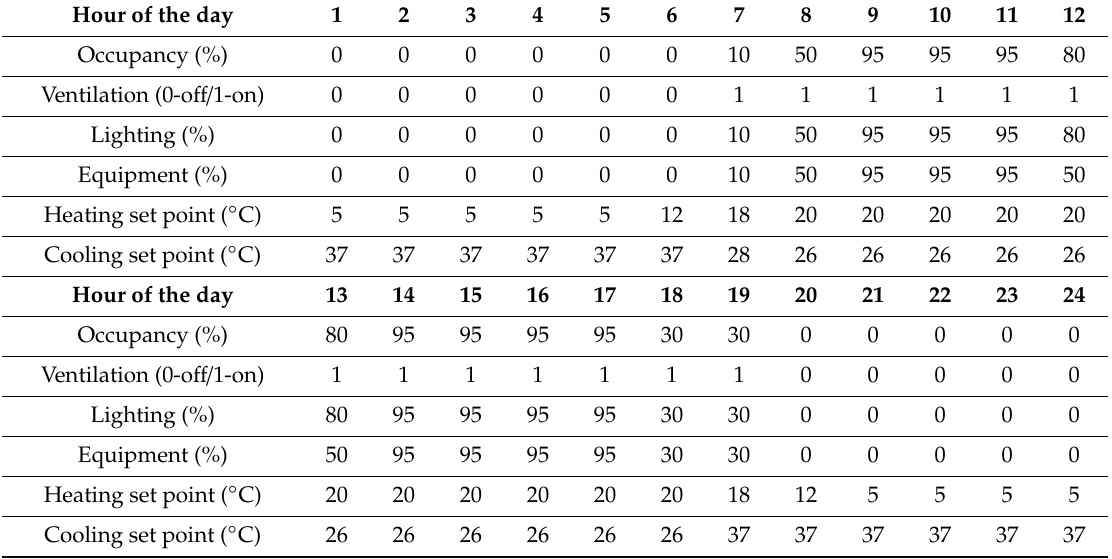
Table 5. Zone Schedules on working days 1